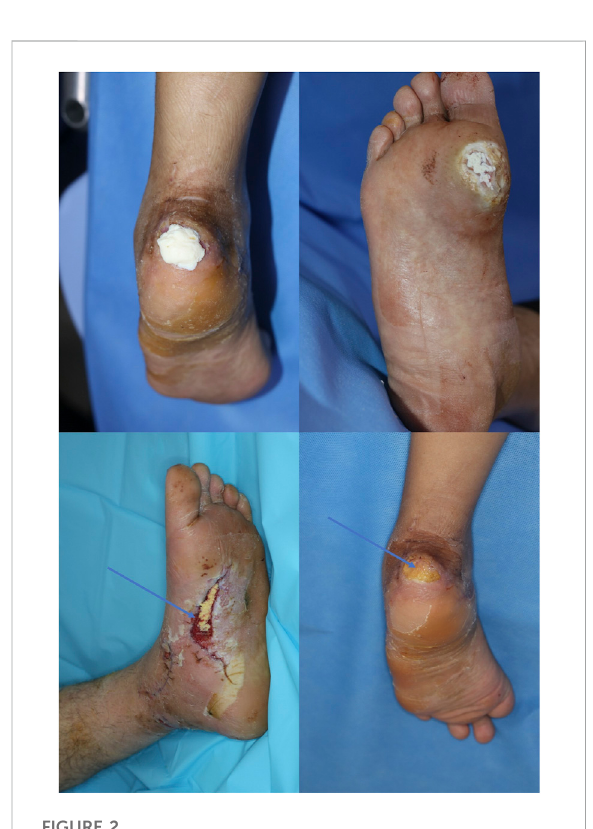
FIGURE 2 Clinicalapplicationofpure-grindADMinlowerextremityskin defects. Immediate images after application of pure-grind ADM (above, left and right). Well-taken pure-grind ADM after 3 weeks from application (below, left and right). Whitish ADM was changed to yellow color